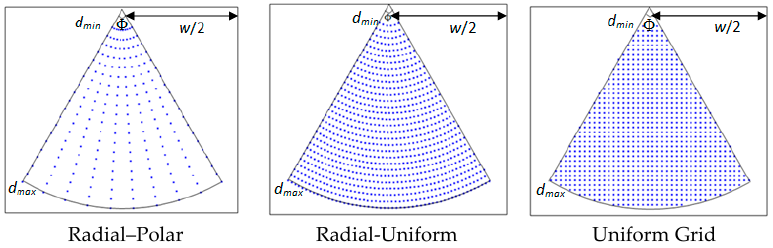
Figure 4. Sampling models that can be used in simulating speckle noise ([13], reproduced with